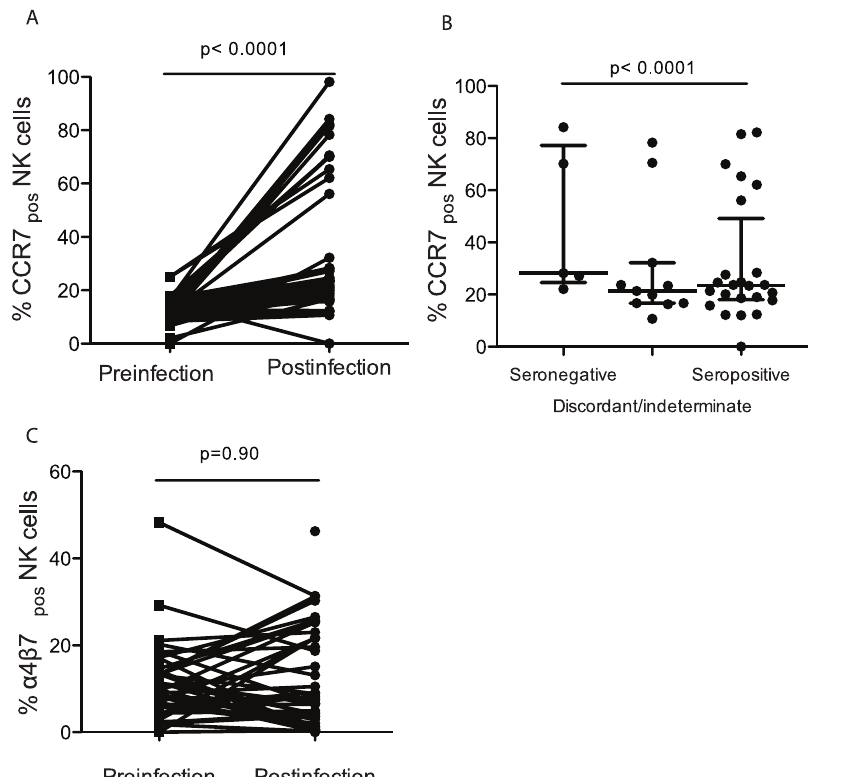
Figure 4. Early after HIV infection blood NK cells increased their expression of lymphoid, but not gut homing receptors. The proportion of NK cells expressing CCR7 was increased following HIV infection (A). The proportion of NK cells expressing CCR7 was reduced during later stages of primary infection (B). The proportion of NK cells that expressed a 4 b 7, was not changed during primary HIV-1 infection (C). Figure S1 The gating strategy for defining NK cells that expressed HLA-DR, a marker of activation, in matched samples obtained pre-infection (A) or post-infection (B), included (clockwise from top left for A and B) the gating of singlets, with forward (FSC) and side-scatter (SSC) properties consistent with lymphocytes, that were not monocytes (CD14 neg ), B-cells (CD20 neg ) or dead cells